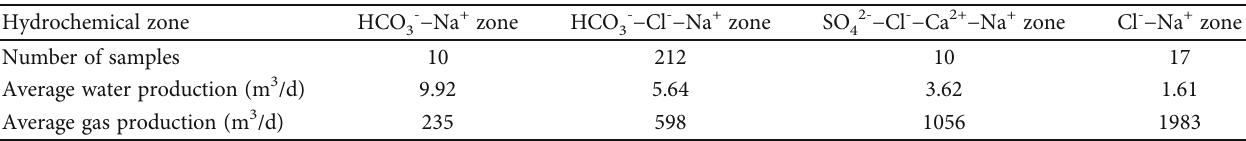
Table 6: Water production and gas production of CBM wells in di ff erent hydrochemical zones of the No. 11 coal seam in the Hancheng mining area